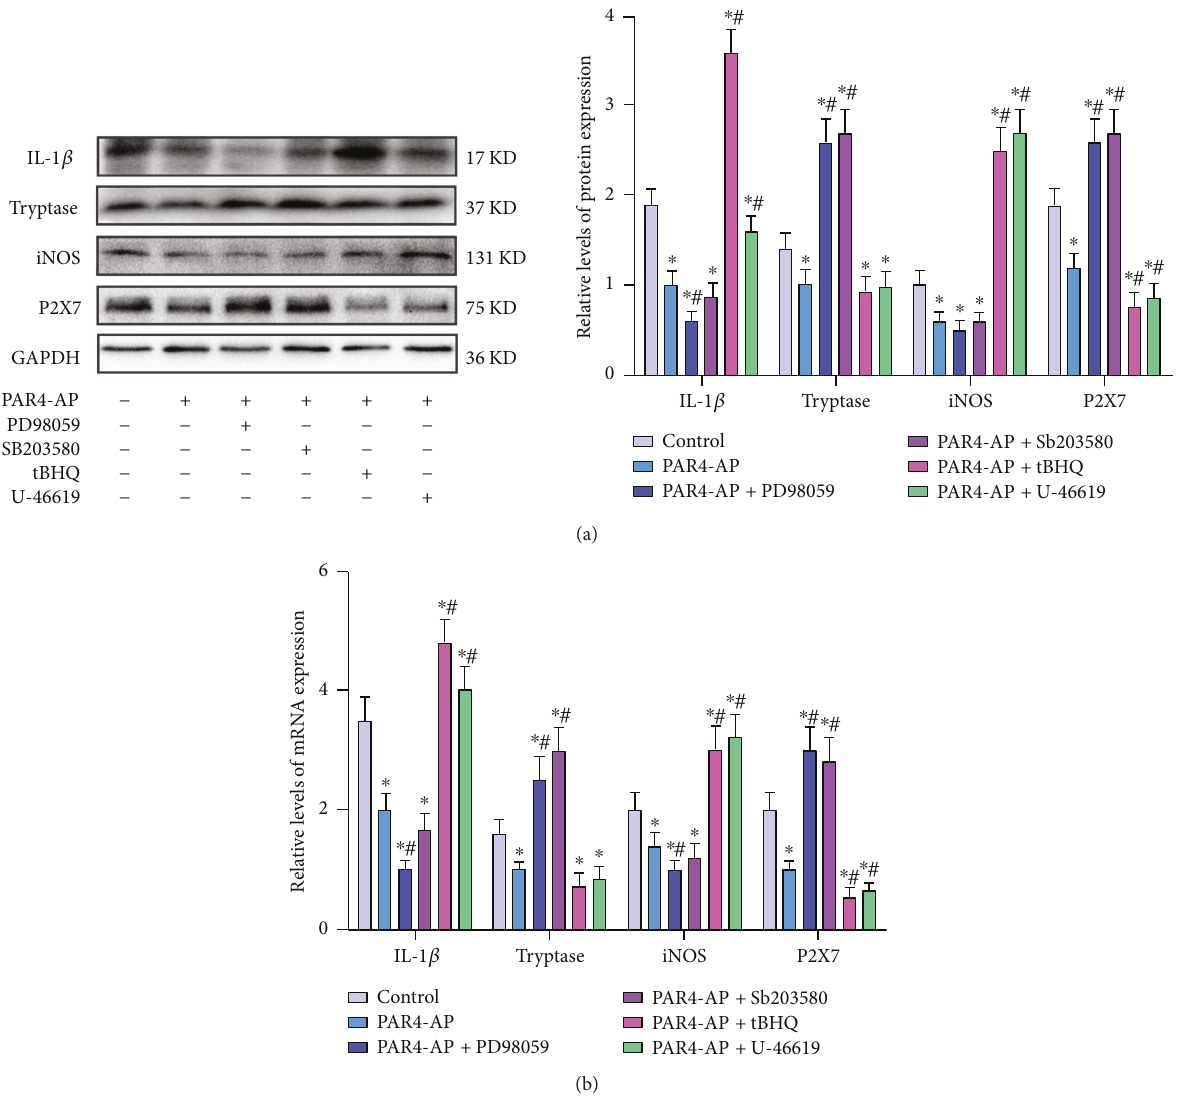
Figure 5: E ff ect of MAPK on PAR4-AP-evoked tryptase, iNOS, IL-1 β , and P2X7 protein and mRNA expressions in BMMCs. (a) Western blotting analyses for tryptase, iNOS, IL-1 β , and P2X7 protein expression in BMMCs following treatment with PAR4-AP and pretreatment with U-46619 (an activator of ERK1/2 and p38), tBHQ (an activator of ERK1/2), PD98059 (an inhibitor of ERK1/2), or SB203580 (an inhibitor of p38). The mean optic densities of the proteins were calculated by normalizing to GADPH. (b) Quantitative RT-PCR analyses of tryptase, iNOS, IL-1 β , and P2X7 mRNA expression in BMMCs following treatment of the BMMCs with PAR4-AP and pretreatment with U-46619, tBHQ, PD98059, or SB203580. The results were calculated by normalizing to β -actin in the same sample with the Δ Ct method. The changes in the relative mRNA levels are expressed as fold changes compared with the controls. All values are expressed as the means ± SEMs ( n = 3 ). ∗ P < 0 05 versus controls; # P < 0 05 versus PAR4-AP-only